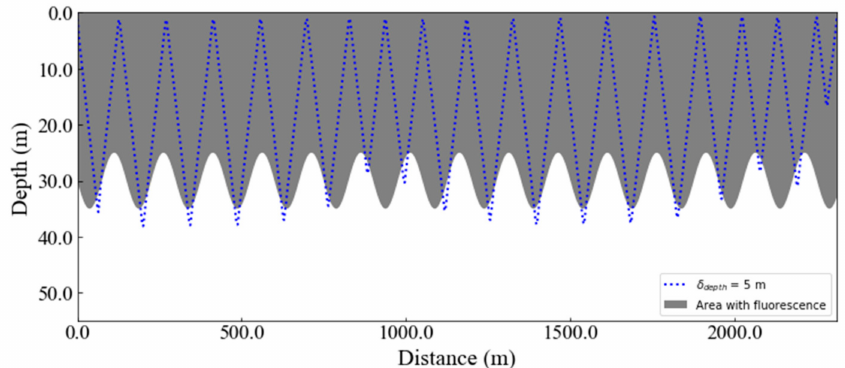
Figure 11. The depth of the glider under the control of a depth controller, which changed the maximum dive depth according to a simplified fluorescence field ( δ depth = 5